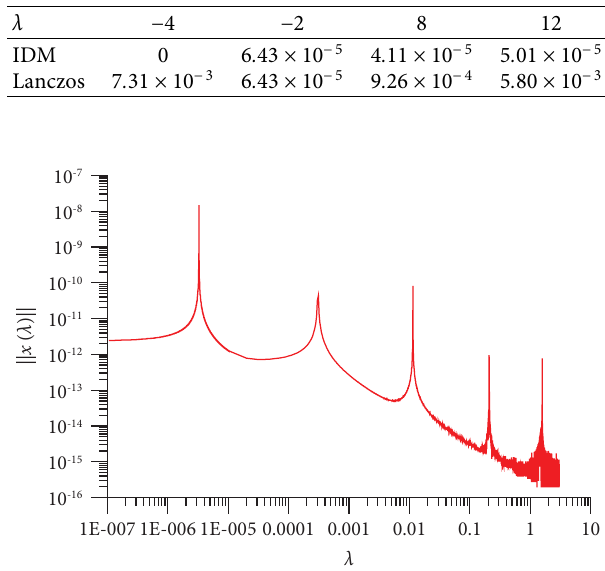
Figure 13: For Example 11, showing fve picks of ‖ x ‖ , corre- sponding to the eigenvalues of Hilbert matrix with n �